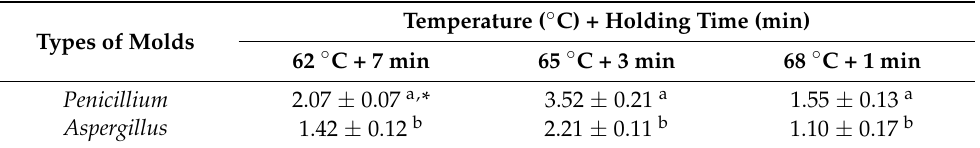
Table 1. Population reductions (mean ± SD, log CFU g − 1 ) of Penicillium and Aspergillus inoculated in almond kernel flour with an a w of 0.854 under the three treatment conditions.